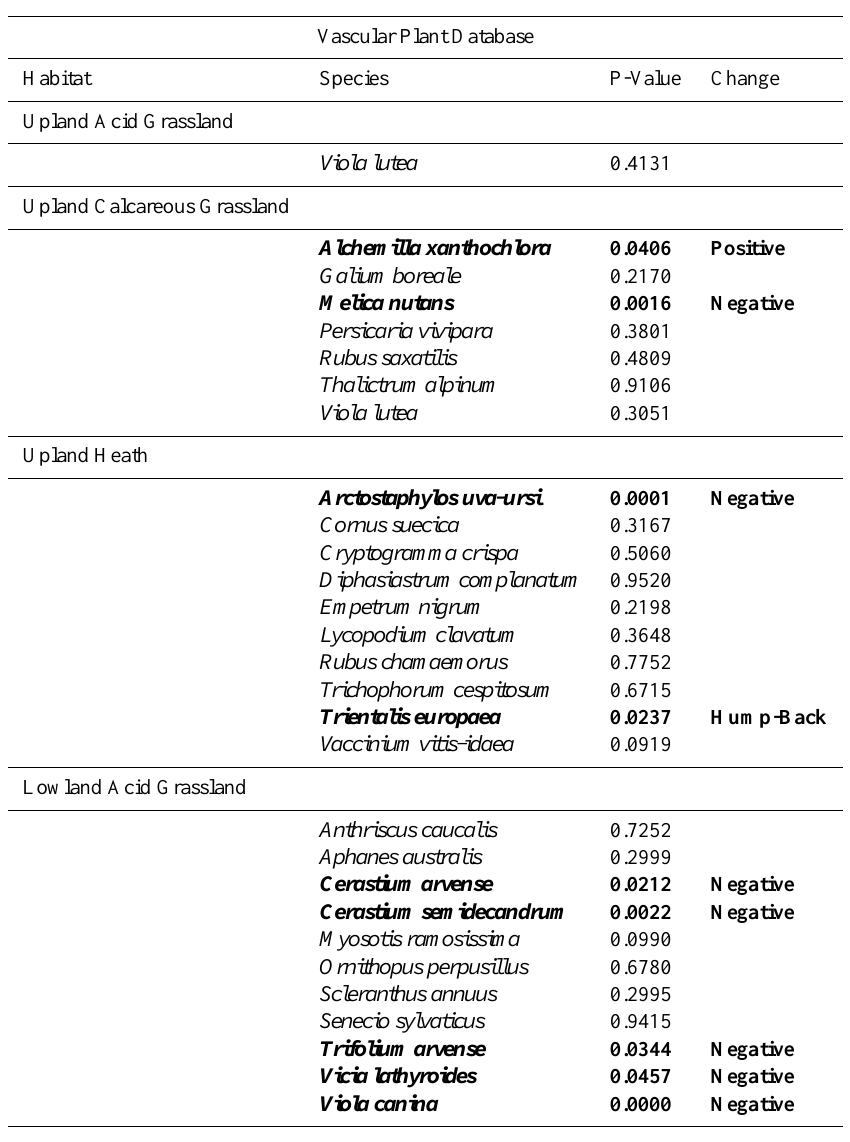
Table B1. Full table of results showing the p-values testing the null hypothesis that there is no relationship between species occur- rence and N deposition. Significant results are